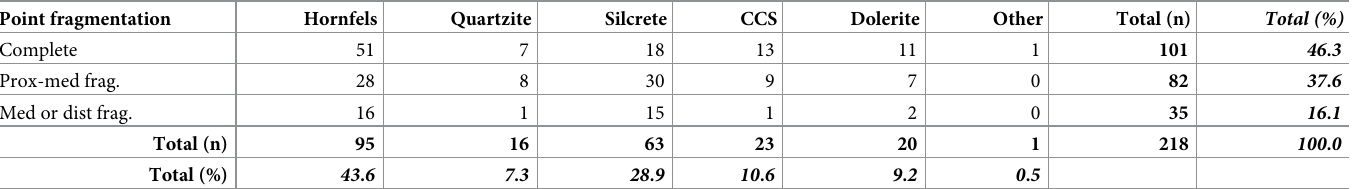
Table 8. Frequencies of point fragmentation at Tweefontein by raw material.